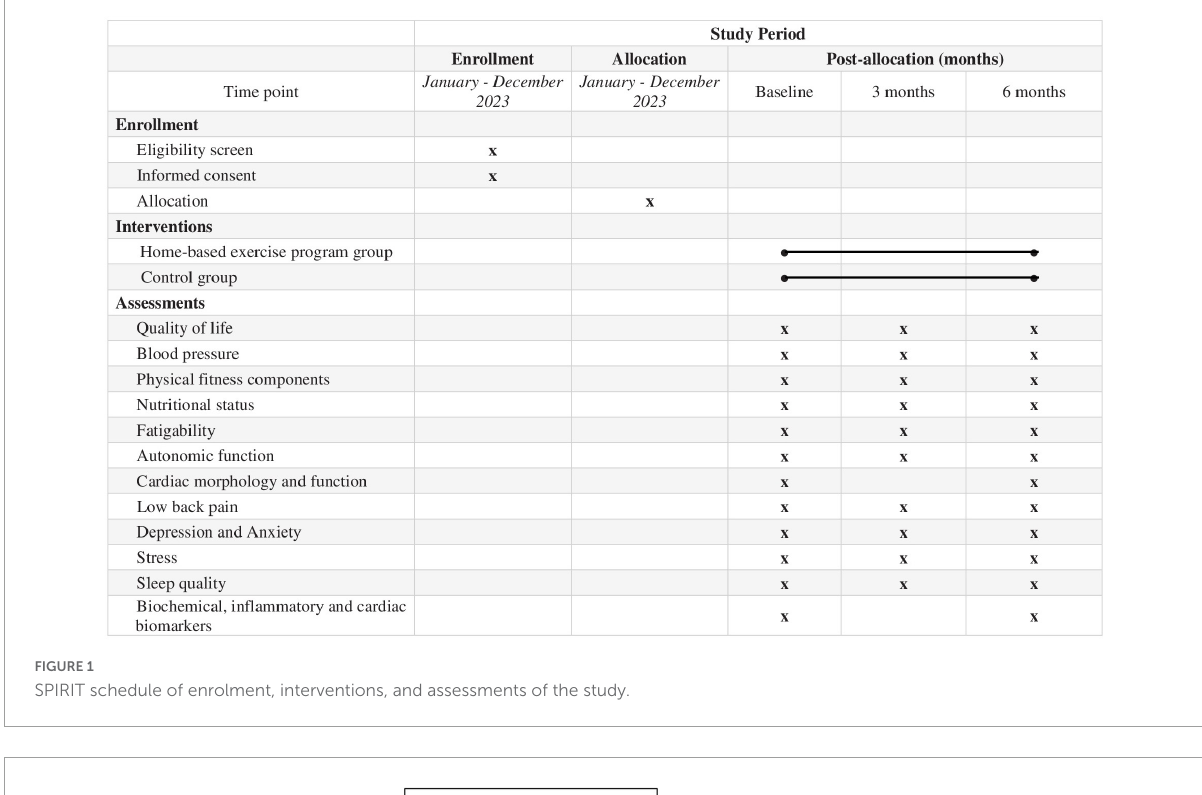
FIGURE1 SPIRIT schedule of enrolment, interventions, and assessments of the study.